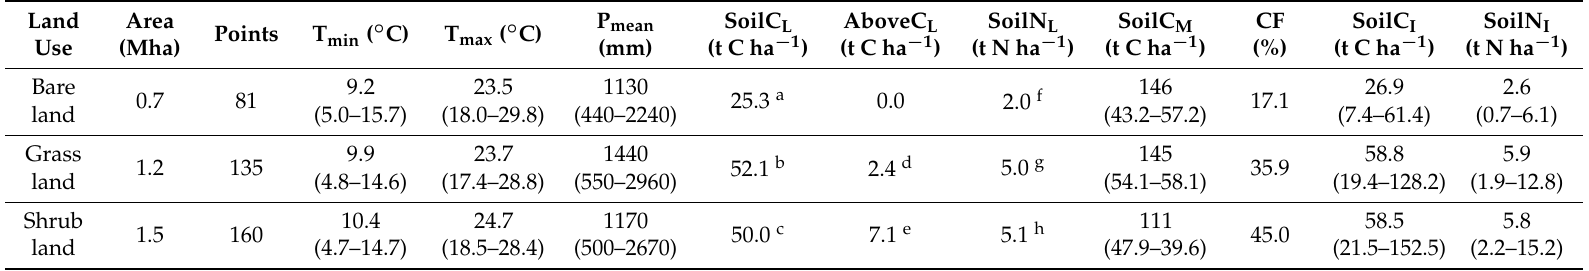
Table 1. Site characteristics and initial conditions of identified reforestation areas. The size of each land use in million hectares (Area), number of simulation points (Points), mean daily minimum temperature (T min ), mean daily maximum temperature (T max ), mean annual precipitation (P mean ), literature derived current soil carbon (SoilC L ), aboveground carbon (AboveC L ) and soil nitrogen (SoilN L ), median soil carbon from spin-up simulations (SoilC M ) representing the theoretical maximum, correction factor (CF) calculated as the ration of SoilC L and SoilC M and results for the initial soil carbon stocks (SoilC I ) derived from the spin-up results of